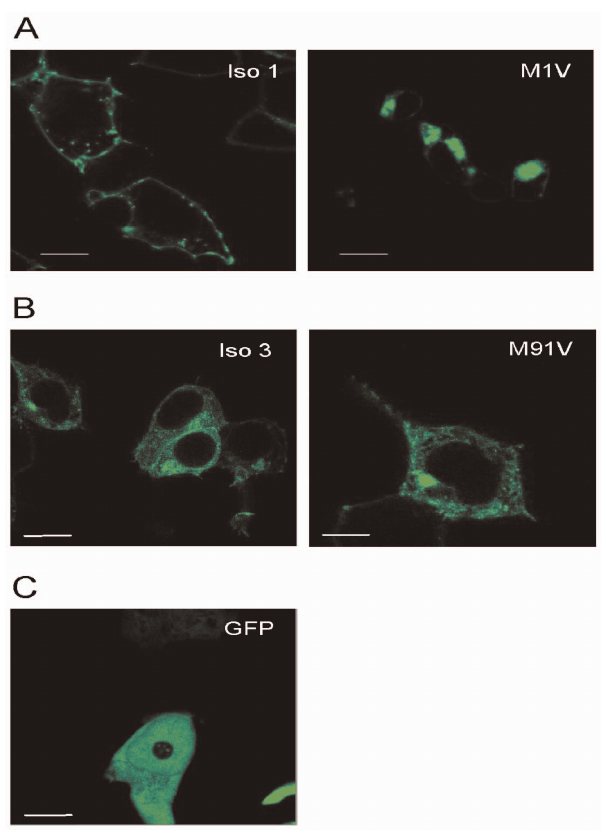
Figure 2. Localization of C-terminally GFP-tagged EDNRB fusion proteins in HEK293 cells. A: HEK293 cells were transiently transfected with wild-type EDNRB isoform 1 (Iso 1) or mutant EDNRB isoform 1 (M1V). Signals were observed at the plasma membrane in cells expressing wild-type isform 1 while signals were detected in the cytosol in cells transfected with mutant isoform 1. B: HEK293 cells were transiently transfected with wild-type EDNRB isoform 3 (Iso 3) or mutant EDNRB isoform 3 (M91V). Signals were found in the cytosol in cells transfected with either wild-type or mutant isoform 3. C. HEK293 cells were transiently transfected with GFP vector only. Shown are the representative iamges. Bars, 50 m m.